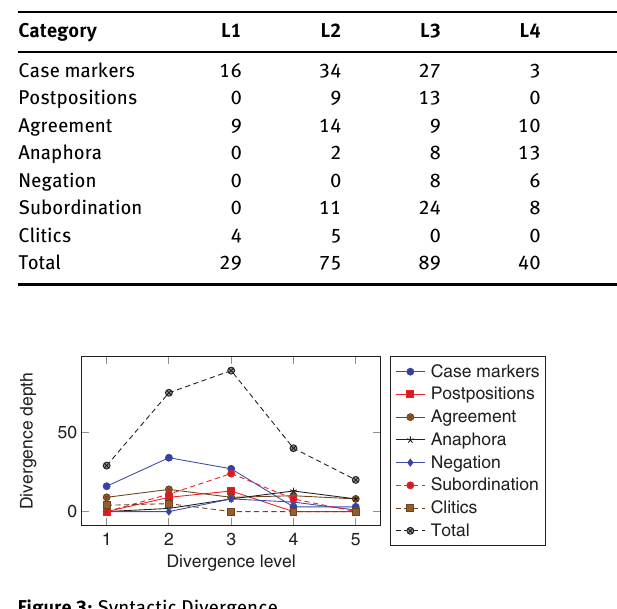
Figure 3: Syntactic